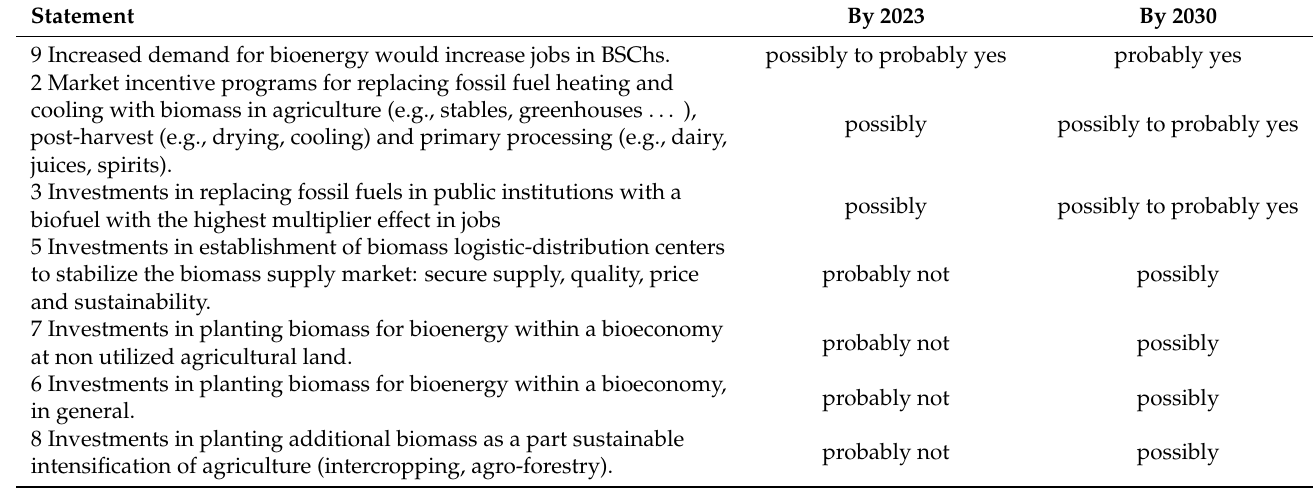
Table 8. Aggregated experts’ consensus on the impact of the investments in BSChs on job creation, across different scenarios. Statement By 2023 By